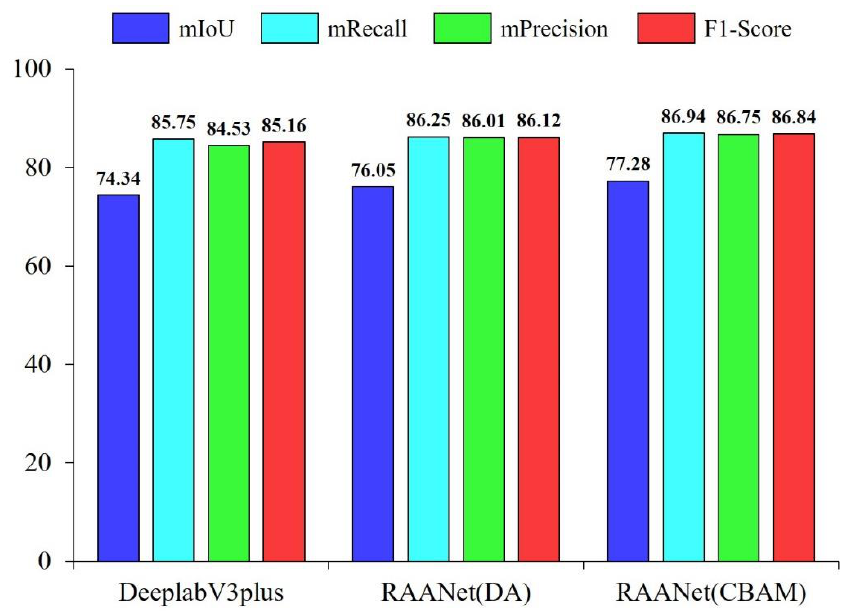
Figure 6. Overall performance of DeeplabV3plus, RAANet (DA), and RAANet (CBAM).